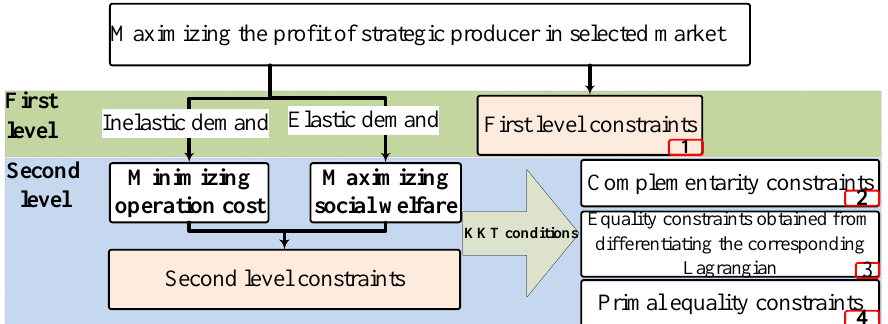
Figure 2. The conversion of the bi-level optimization solution to a